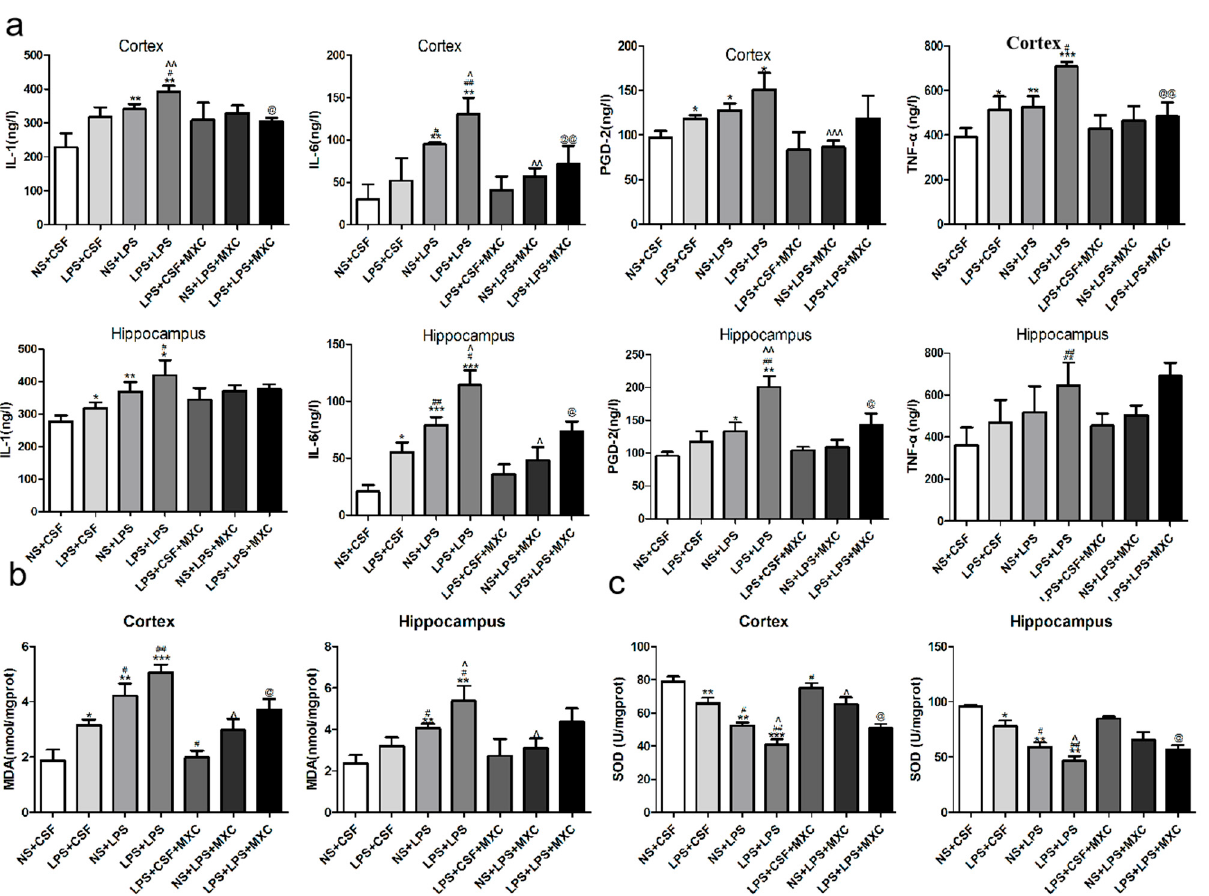
Figure 4. Effect of MXC on the levels of inflammatory factors and oxidative stress in LPS-treated offspring from prenatal inflammation exposure: ( a ) Effect of MXC on the levels of PGD-2, TNF- α , IL-1 β , and IL-6 in LPS-treated offspring from prenatal inflammation exposure. Different protein expressions levels were determined through ELISA kits. ( b ) Effect of MXC on the MDA levels in LPS-treated offspring after prenatal inflammation exposure. ( c ) Effect of MXC on the SOD activity in LPS-treated offspring after prenatal inflammation exposure (right). Data are mean ± SEM, n = 4. (* p < 0.05, ** p < 0.01, *** p < 0.001 vs. NS + CSF group; # p < 0.05, ## p < 0.01 vs. LPS + CSF group; ^ p < 0.05, ^^ p < 0.01, ^^^ p < 0.001 vs. NS + LPS group; @ p < 0.05, @@ p < 0.01 vs. LPS + LPS group) .